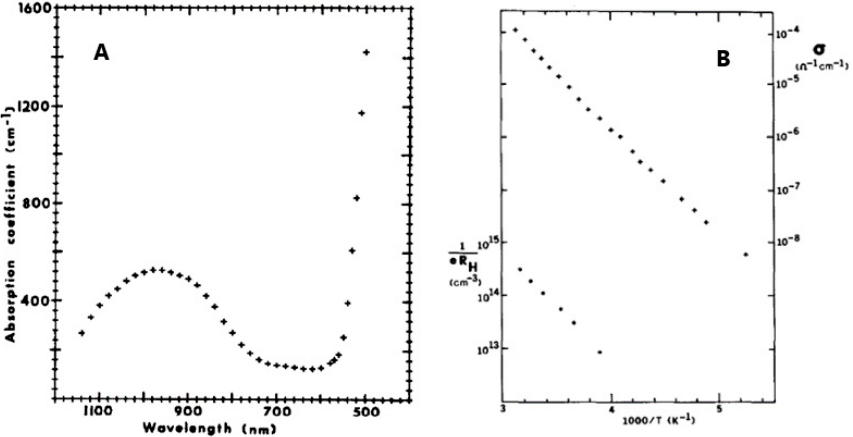
Figure 8. ( A ) Optical absorption spectrum of GFO single crystal at room temperature; ( B ) Conduc- tivity (+) and hole concentration ( • ) of GFO single crystal as a function of temperature. Ref. [15] Reproduced with permission, Copyright Elsevier 1980.